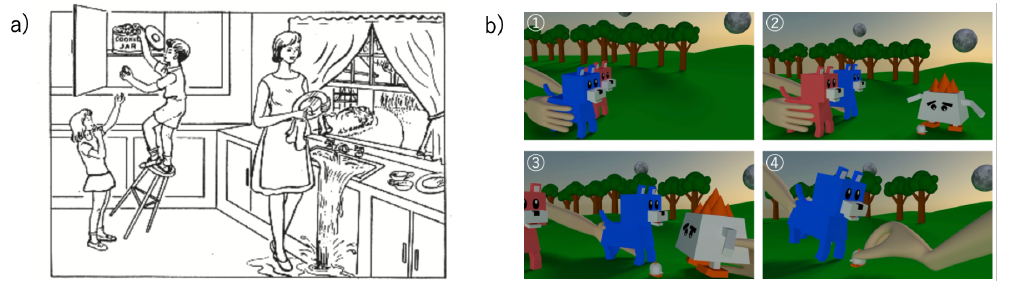
Figure 1. ( a ) Images used in picture description tasks (copyright Goodglass). ( b ) Movie used in the animation description task (public domain).